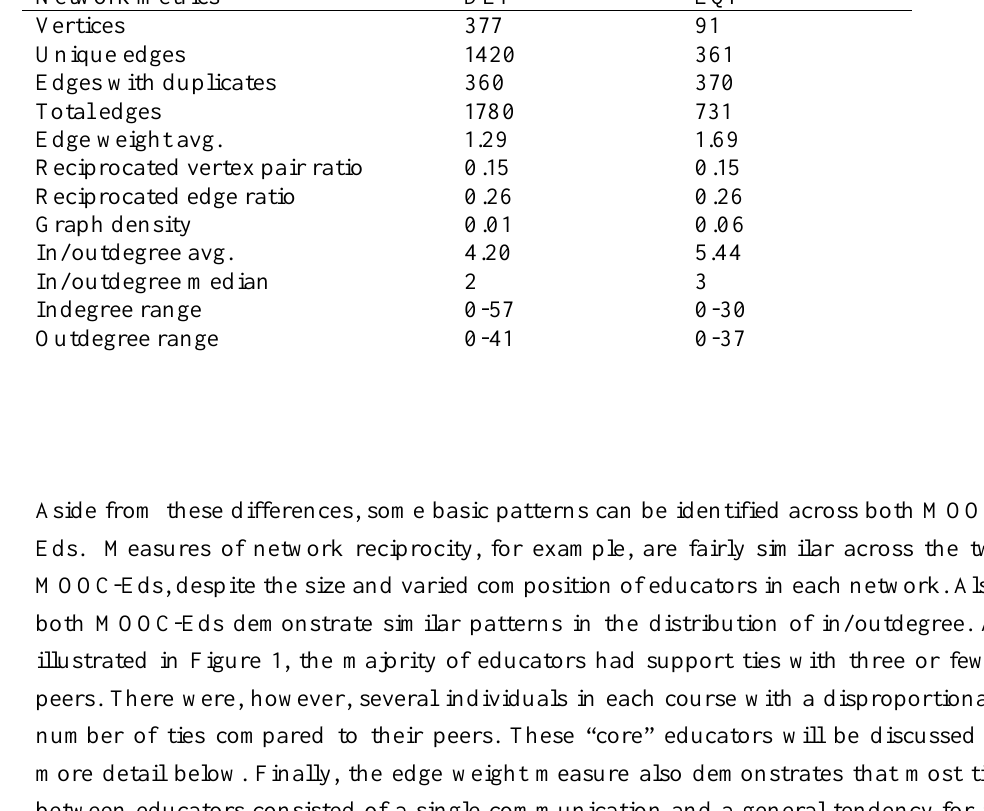
Overall Network Measures for each MOOC-Ed Network